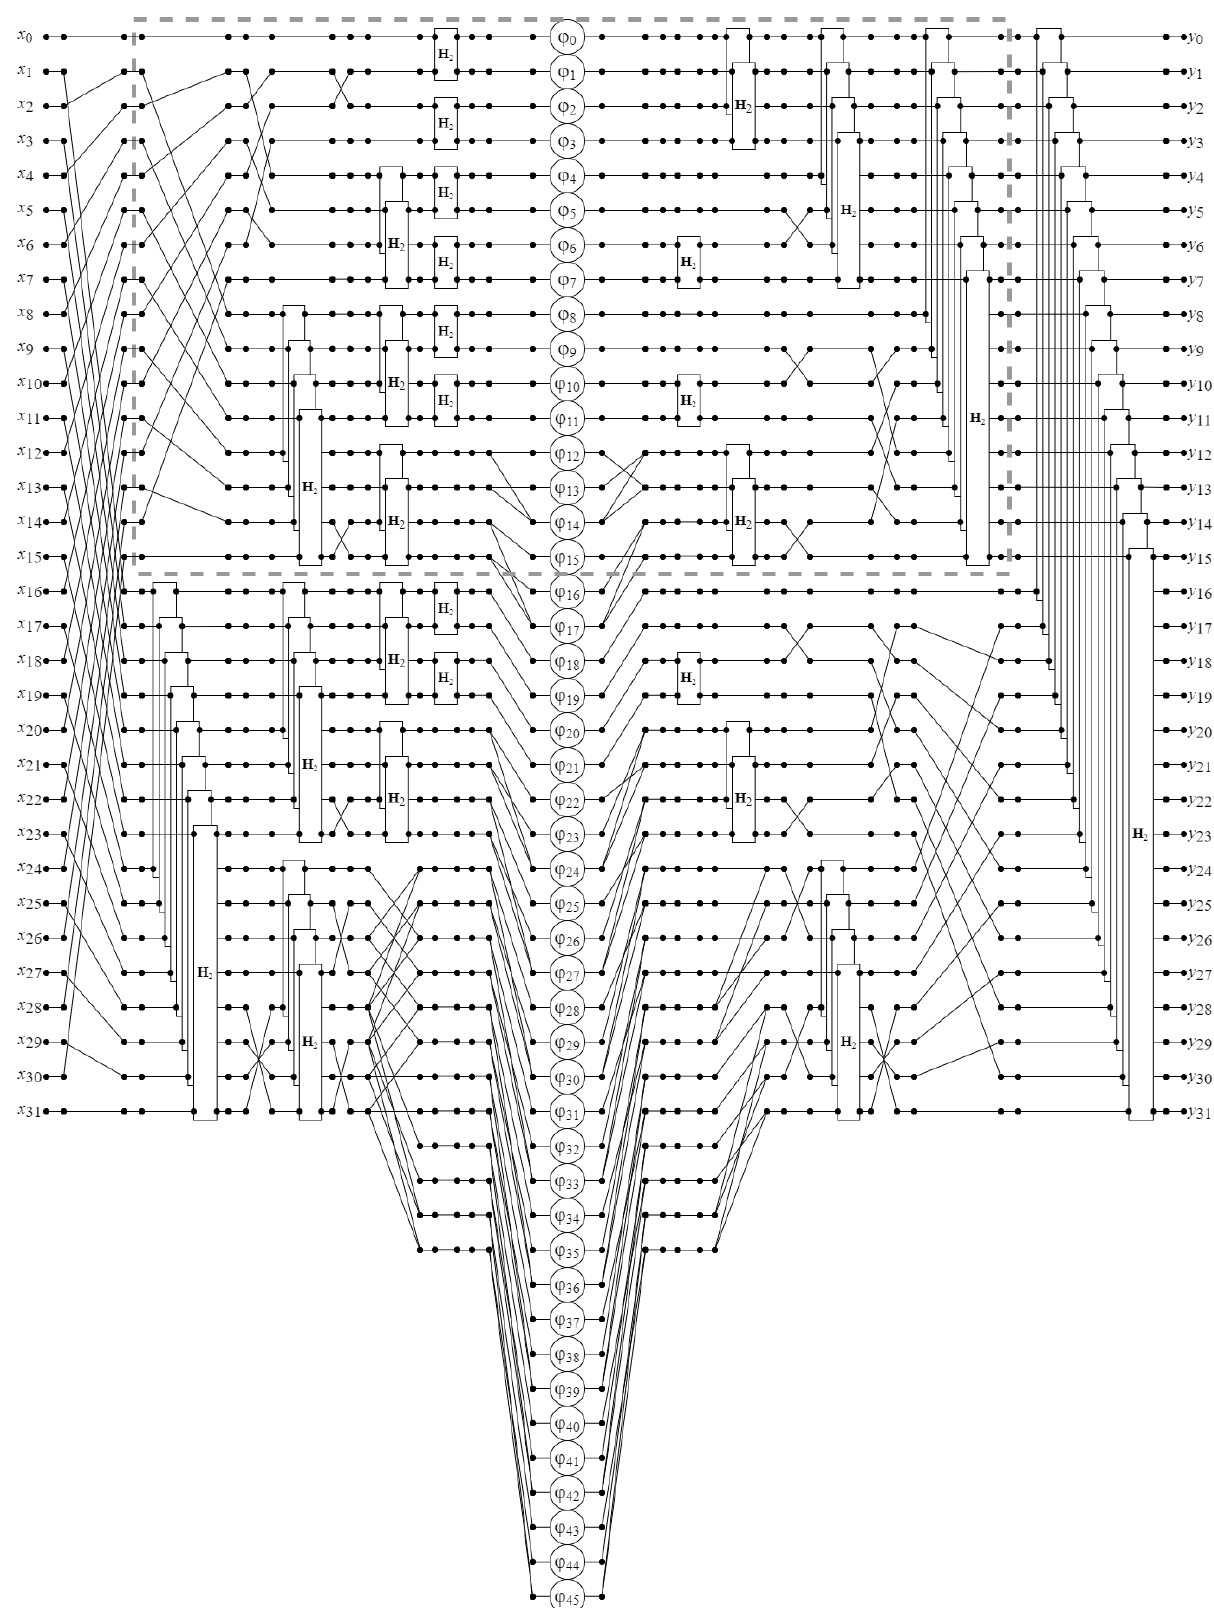
Figure 4. The data flow graph of the proposed algorithm for computation of 32-point